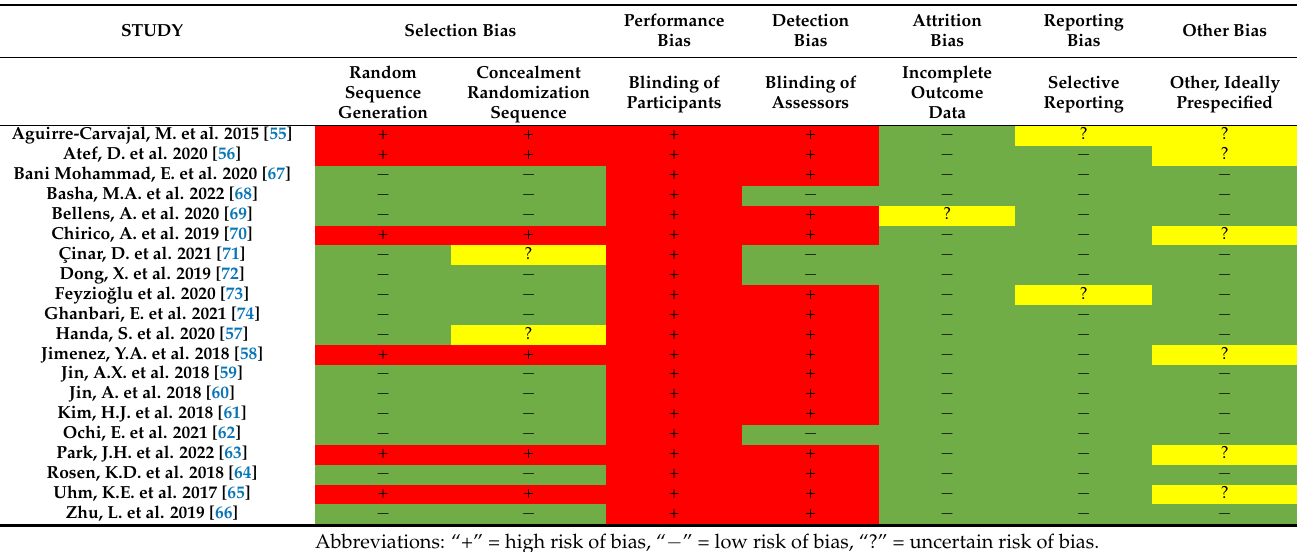
Table 3. Risk of bias assessment of the included studies.